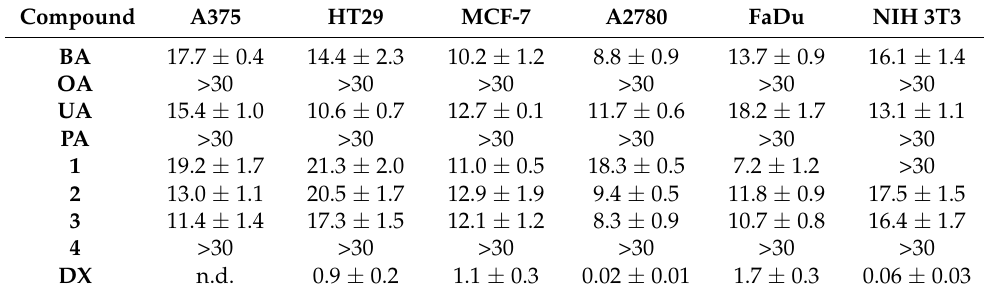
Table 1. Cytotoxicity of parent compounds BA , OA , UA , and PA as well as of their corresponding acetates 1 – 4 (EC 50 -values in µ M from SRB-assays) after 72 h of treatment; the values are averaged from three independent experiments performed each in triplicate, confidence interval CI = 95%; mean ± standard mean error); n.d. not determined; doxorubicin ( DX ) was used as a positive control. Cell lines: malignant: A375 (melanoma), HT29 (colon adenocarcinoma), MCF-7 (breast adenocarcinoma), A2780 (ovarian carcinoma), FaDu (hypopharyngeal carcinoma); non-malignant: NIH 3T3 (fibroblasts).